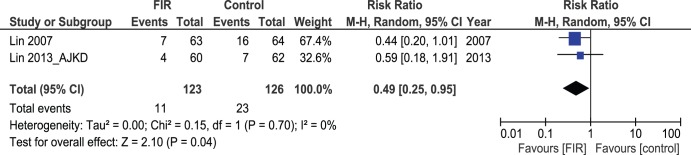
Forest plot showing surgical intervention for AVF malfunction.